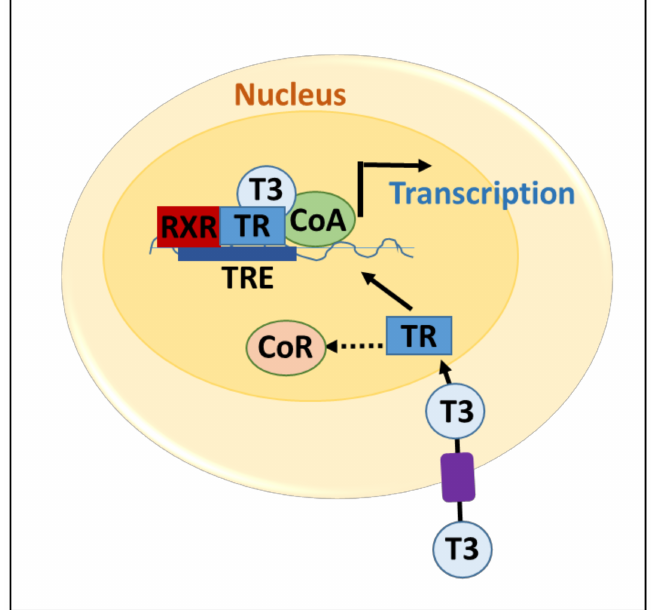
Figure 1. Thyroid hormone receptor-mediated transcription. T3 enters the target cell through membrane transport. T3 enters the nucleus and binds to the thyroid hormone receptor (TR). TR then releases the co-repressor (CoR), dimerizes with the retinoid X receptor (RXR), and recruits the co-activator (CoA) complex. This complex binds the T3 response element (TRE) to activate transcription of target